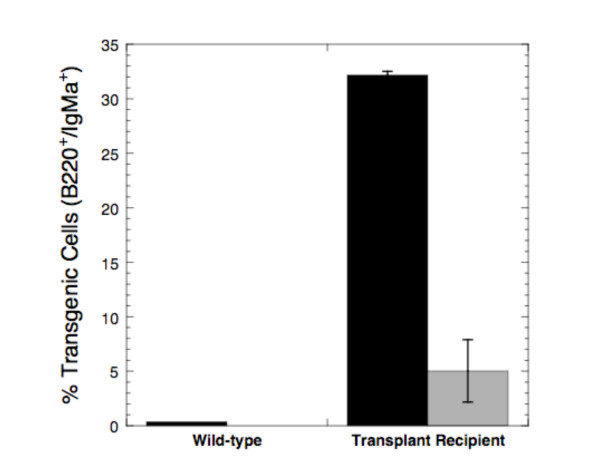
Tumor cells decrease in SCH66336-treated mice. Splenocytes were isolated and stained with antibodies to IgMa and B220 to detect the transgenic lymphoma cells. The percent of viable splenocytes positive for both markers is shown for unmanipulated C57BL/6 mice (Wild-type) or mice transplanted with 106 tumor cells 18 days earlier (Transplant recipient). Results from untreated mice are shown with black bars and from transplant-recipient mice treated with 1.56 mg SCH66336 by oral gavage twice daily for 3 days with shaded bars. The average and standard deviation for 4 mice in each group is shown.